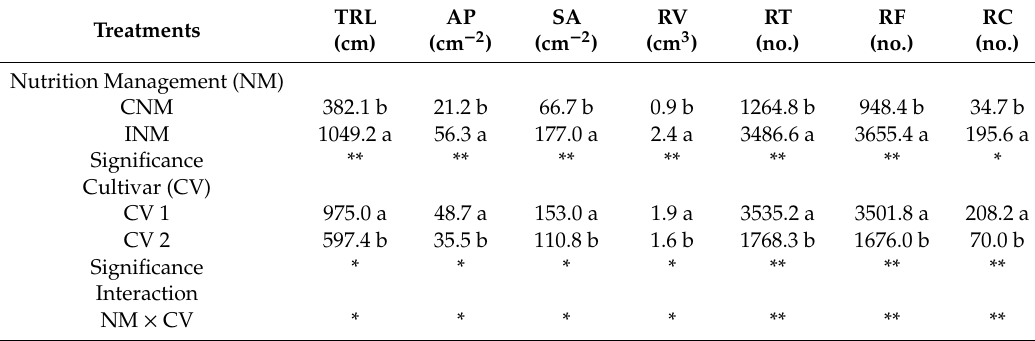
Table 5. Main e ff ects of nutrient protocol management and cultivar on total root length (TRL), area projection (AP), surface area (SA), root volume (RV), root tips (RT), root forks (RF), and root crossings (RC) at 2011 harvest period in chrysanthemum plants.